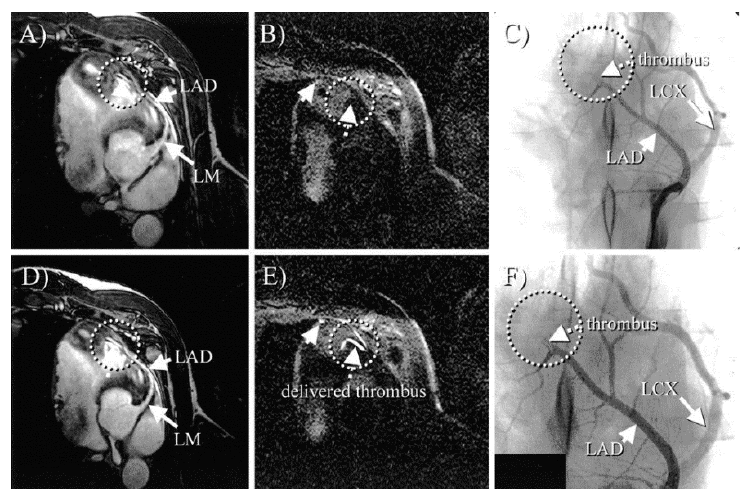
Figure 11. In vivo MRI of Gd-labelled fibrinogen clots. ( A ) and ( D ), Coronary MRA before ( A ) and after ( D ) thrombus delivery. On both scans, no apparent thrombus is visible (circle). ( B ) and ( E ), Black- blood inversion recovery TFE scans before ( B ) and after ( E ) clot delivery (same view as ( A ) and ( D ). After thrombus delivery ( E ), three bright areas are readily visible (arrows and circle), consistent with location of thrombus. No apparent thrombus was visible on prethrombus ( B ) images (arrow and circle). ( C ), X-ray angiogram confirming MR finding of thrombus in mid-LAD (circle). ( F ), Magnified view of (C) . LM indicates left main; LAD indicates left anterior descending artery; LCX indicates left circumflex artery. Reproduced with permission from Botnar et al., 2004 [77].